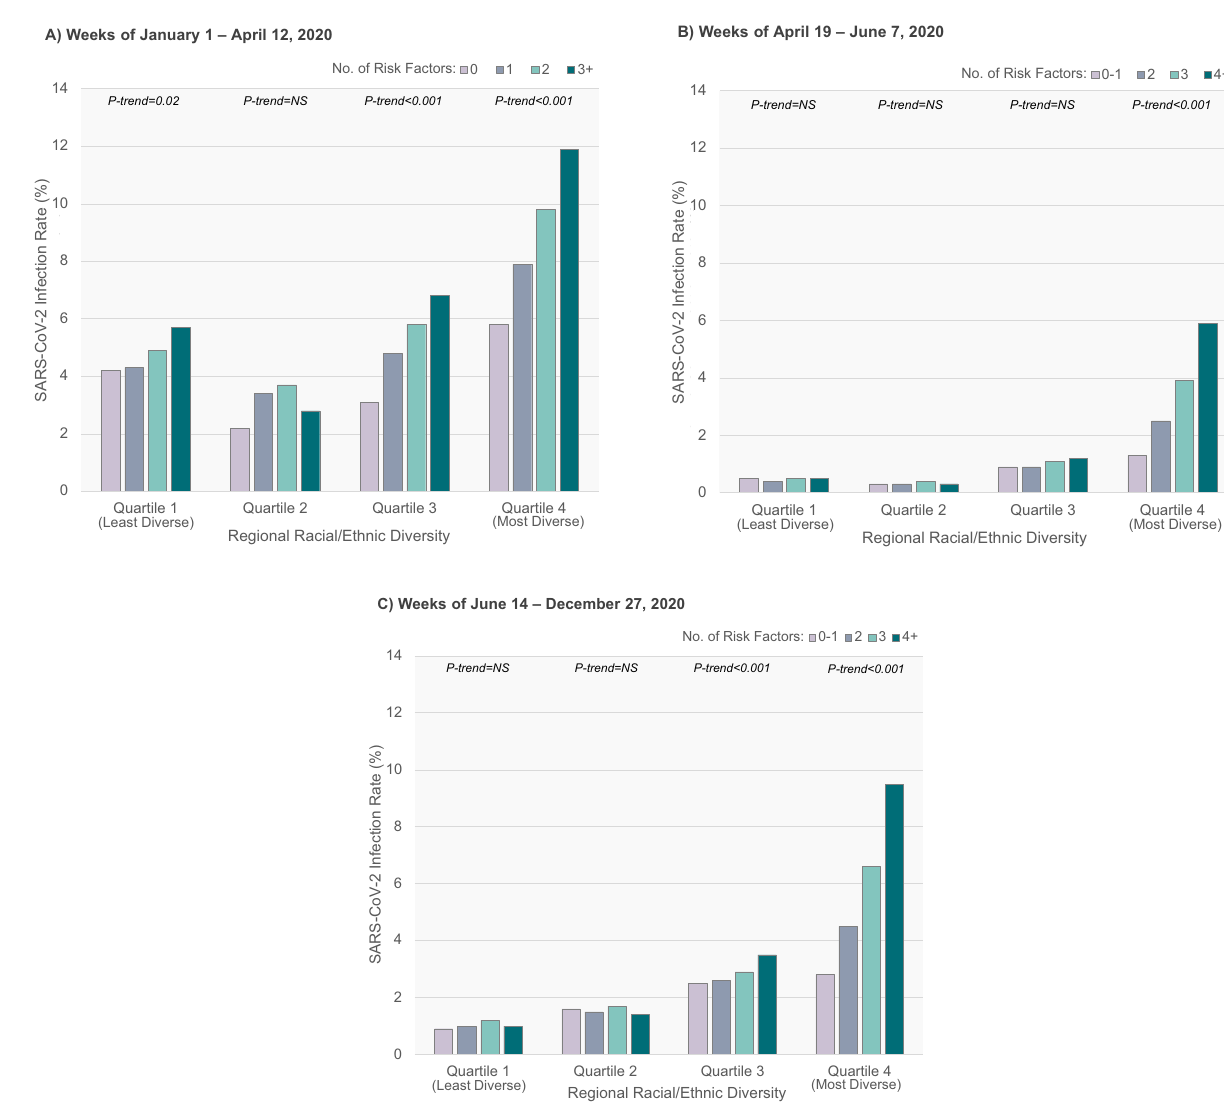
Figure 2. SARS-CoV-2 infection rates by number of risk factors and degree of regional racial/ethnic diversity, prior to ( A Weeks of January 1–April 12, 2020) and following ( B Weeks of April 19–June 7, 2020 and C Weeks of June 14–December 27, 2020) the peak of the first wave of the pandemic in Ontario, Canada. Individuals were classified according to the number of potential risk factors present. Risk factors prior to the first wave were comprised of: male sex, age > 45 years, lowest quintile of neighborhood income, Canadian immigrant, history of frailty, hypertension, and diabetes; following the first wave: male sex, age < 85 years, neighborhood income quintiles 1–4, Canadian immigrant, hypertension, and diabetes. Region was categorized by quartiles of community racial/ethnic diversity